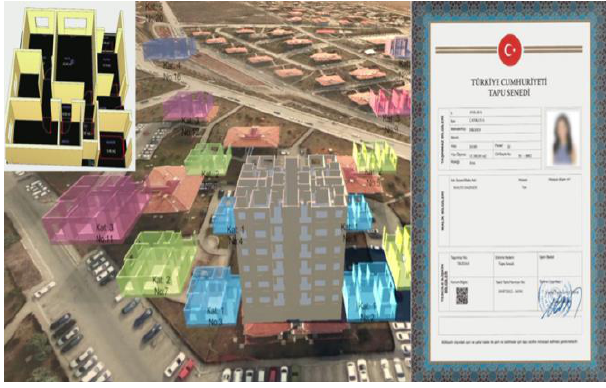
Figure 1. Sample 3D Building.